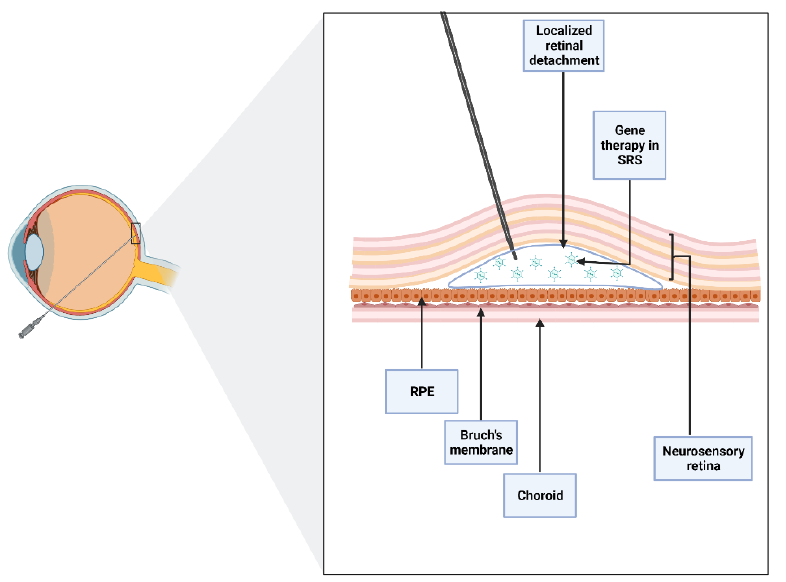
Figure 1. Schematic of subretinal injection. An iatrogenic retinal detachment is produced after accessing the subretinal space (SRS), the area between the neurosensory and the retinal pigment epithelium (RPE). Subretinal injection allows direct contact of the drug with photoreceptors and RPE layers.